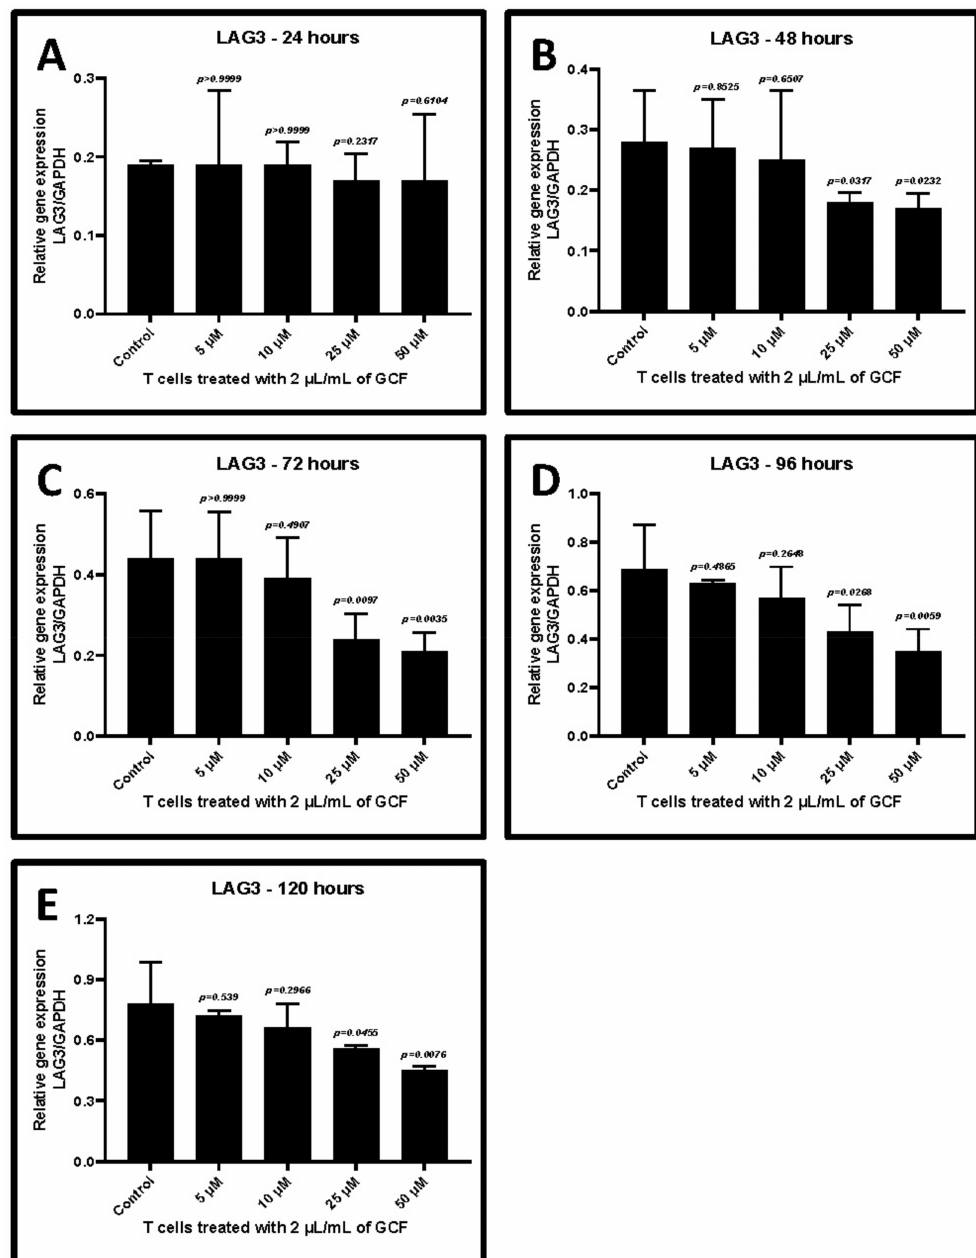
Figure 7. Relative gene expression of LAG-3 in 2 µ L/mL GCF-treated CD3+ T lymphocytes treated with different concentrations of allicin (5, 10, 25, and 50 µ M). ( A ) Comparative gene expression of LAG-3 after 24 h of treatment. ( B ) Comparative gene expression of LAG-3 after 48 h of treatment. ( C ) Comparative gene expression of LAG-3 after 72 h of treatment. ( D ) Comparative gene expression of LAG-3 after 96 h of treatment. ( E ) Comparative gene expression of LAG-3 after 120 h of treatment. LAG-3 : lymphocyte-activation gene 3, GCF: gingival crevicular